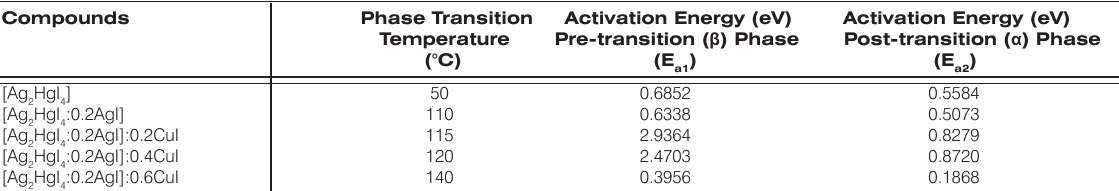
Table 1. Comparative activation energies for ionic conductivity of pure and doped [Ag